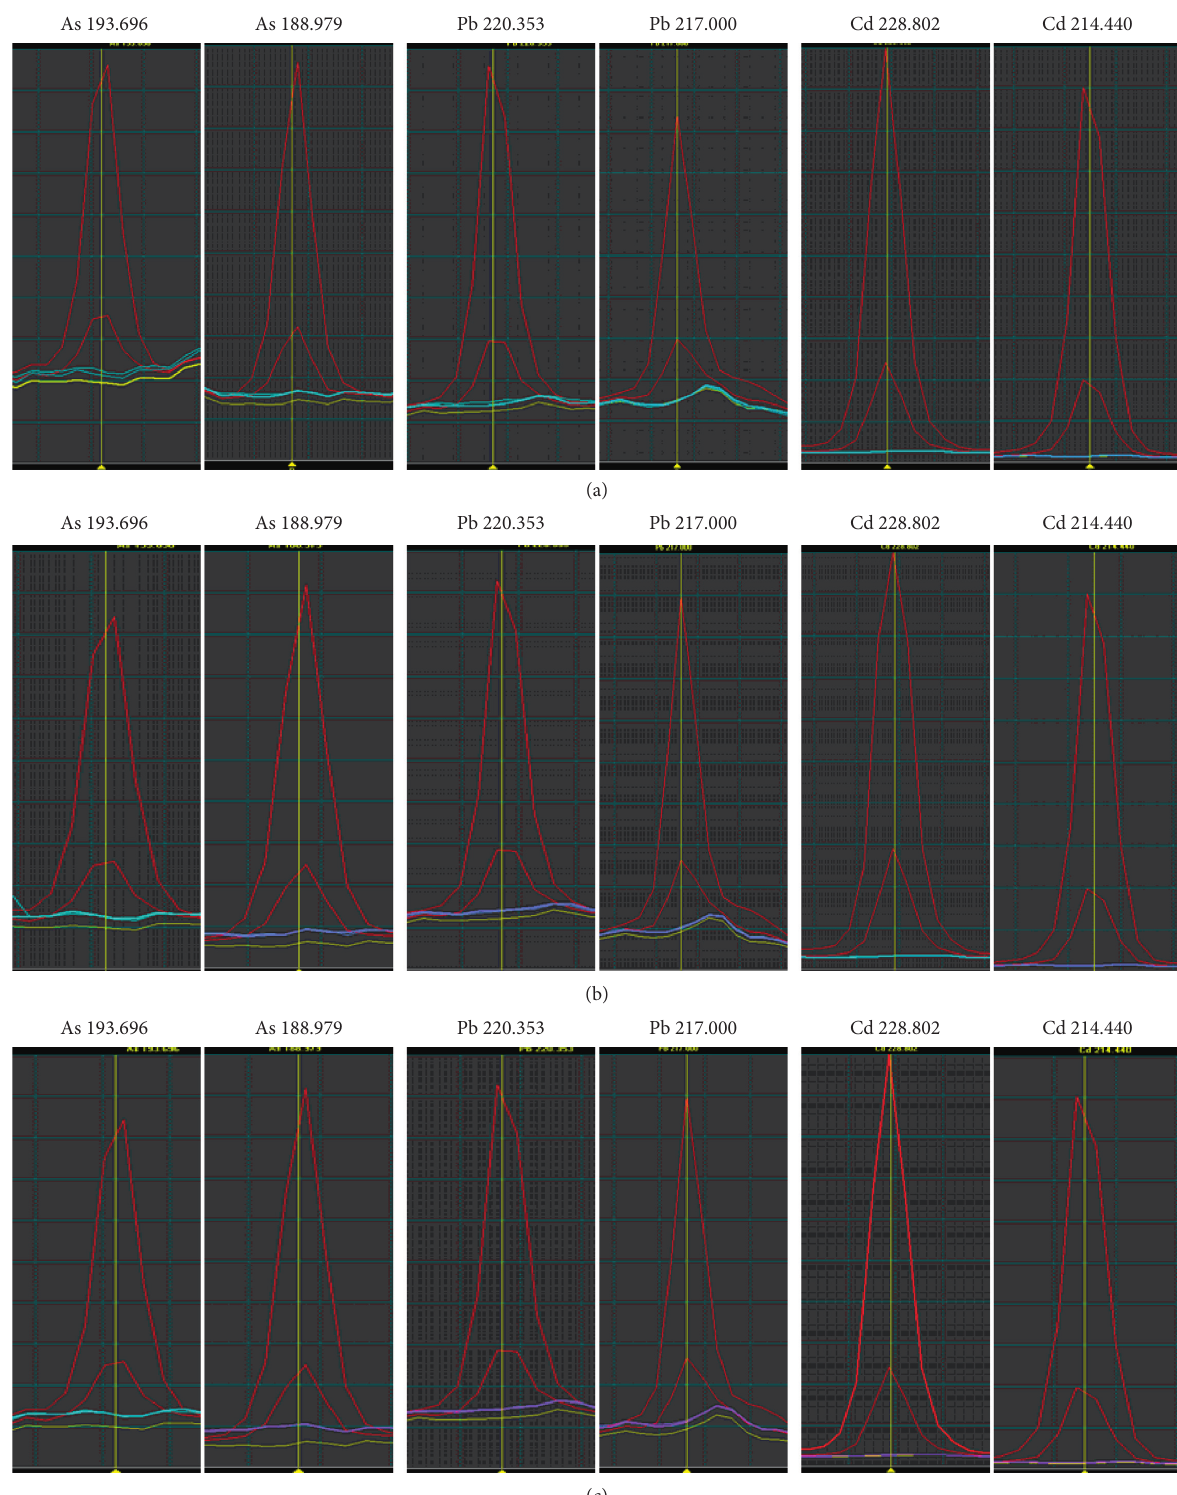
Figure 3: Emission spectra of the 10-fold dilution (turquoise/violet curves) of the oyster shell (a), PCC (b), and MCP (c) samples. The spectra of As are on the left, Pb in the middle, and Cd on the right. The yellow curves for the blank, and the red ones for calibration